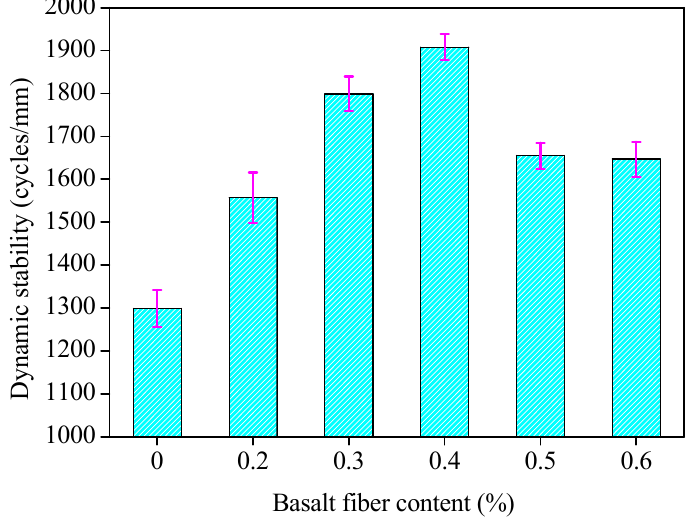
Figure 15. Dynamic stability for fiber-reinforced asphalt mixture with different fiber contents, where the testing temperature was set to 60 °C.